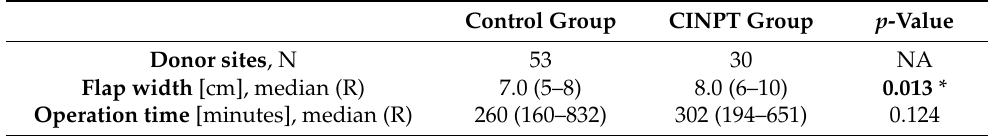
Table 2. Intraoperative